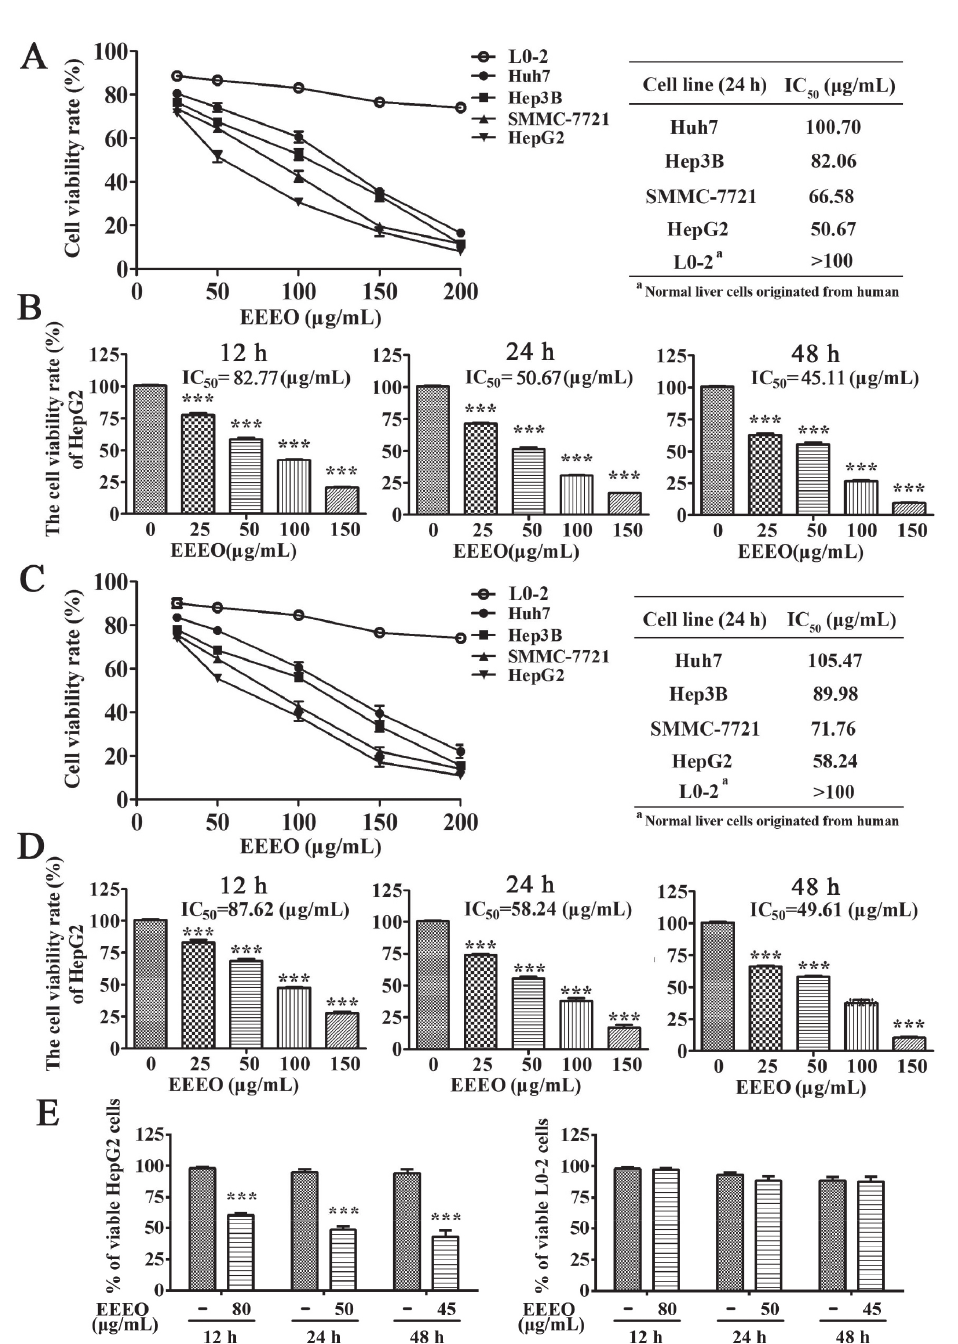
FIGURE 2 - Selective inhibitory effects of EEEO on cells proliferation. (A, B) In MTT assay, EEEO treatment inhibited HCC cells proliferation, but did not induce anti-proliferation in normal liver cells. HepG2 cells showed the most sensitive to EEEO treatment and were inhibited in a time- and dose-dependent manner. Hepatocellular carcinoma cell lines (Huh7, Hep3B, SMMC-7721 and HepG2) and normal liver cell line (L0-2) were treated with 0-150 μg/mL of EEEO for 24 h, and IC values were calculated by 50 MTT assay. The most sensitive cell line was further tested with above concentrations of EEEO for 12 h, 24 h and 48 h. (C, D) values were also calculated by CCK-8 assay in above cell lines. Similarly, HepG2 cells were sensitive to EEEO, and showed IC 50 time and dose-dependent inhibition by EEEO. (E) To verify the anti-proliferative effects and toxicity of EEEO, HepG2 and L0-2 cells were treated with EEEO whose concentrations were approximated with IC values, and trypan blue exclusion staining was 50 performed to measure the percentage of viable cells. In above assay, 0 μg/mL (or labeled as -) of EEEO served as control group. The data is shown as the means ± SD from three independent experiments. Asterisk denote a response that is significantly different from the control (*** P <